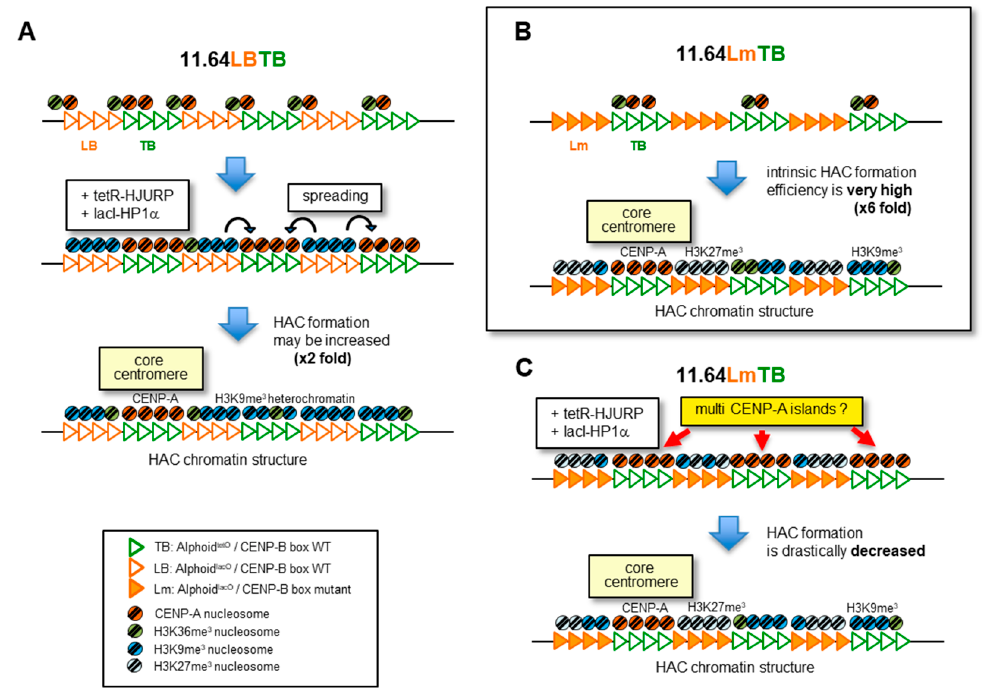
Figure 6. Model of chromatin assembly to establish HACs. ( A ) pBAC11.63LBTB with transient tethering of lacI-CLIP-HP1 α and tetR-EYFP-HJURP. ( B ) pBAC11.63LmTB without tethering. ( C ) pBAC11.63LmTB with transient tethering of lacI-CLIP-HP1 α and tetR-EYFP-HJURP. During the process of establishing HAC, the introduced alphoid BAC circular molecules are recombined and multimerized. Consequently, size variations of the alphoid DNAs arise, but for the sake of brevity, they are shown here at the same size [33–39].